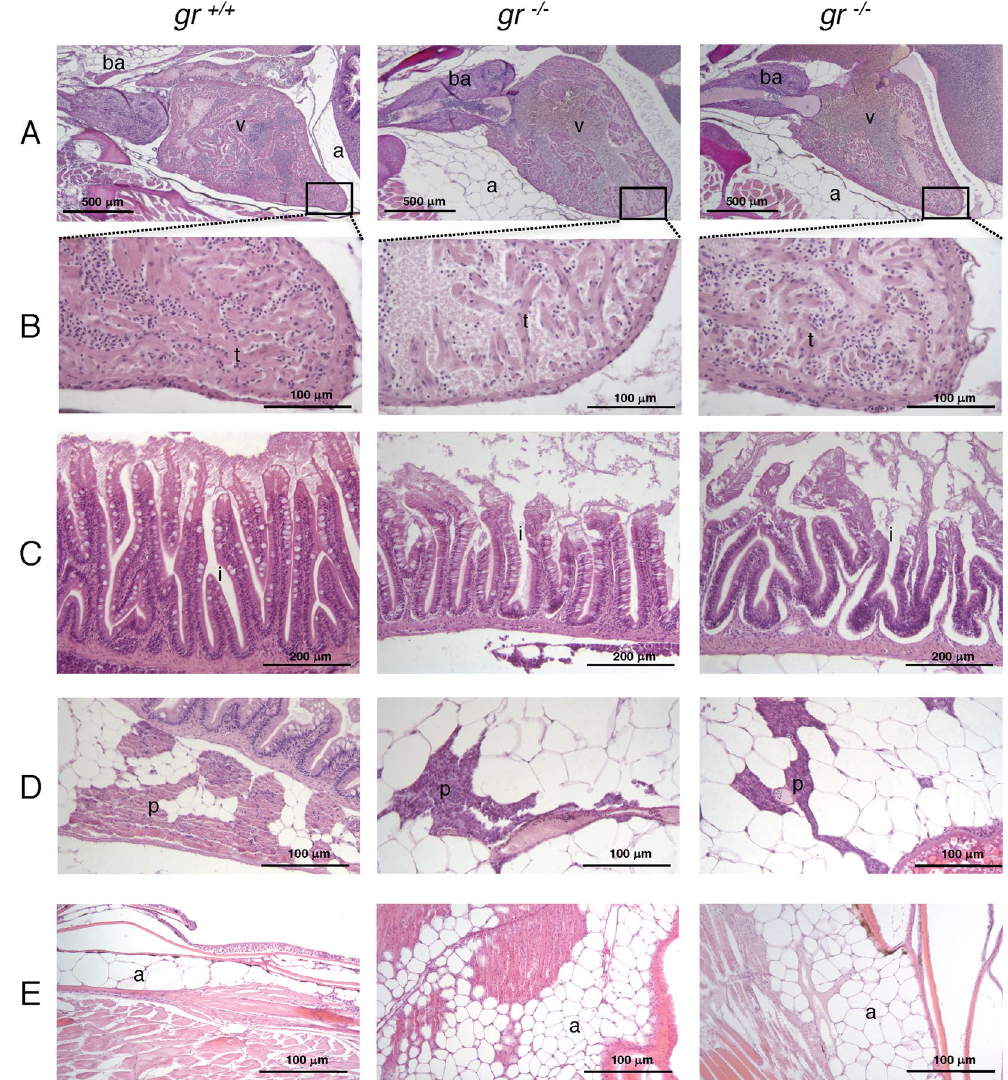
Figure 2. Histology of 8-month-old gr − / − and gr + / + zebrafish. All histological images of 8-month-old gr − / − and gr + / + zebrafish were taken from longitudinal sections stained with haematoxylin and eosin (H&E). The left panels represent wild type fish, whereas the middle and right panels show tissues from two mutant fish. ( A ) heart; ( B ) particular of the heart at higher magnification showing reduced trabecular network in the mutant samples; ( C ) intestinal mucosa with sloughing epithelium at the villous tips and reduced height of villi in mutants; ( D ) visceral view showing reduced extension of pancreas in mutants; ( E ) consistent increase of subcutaneous adipose tissue in mutants. ba = bulbus arteriosus; v = ventricle; a = adipose tissue; i = intestine; p = pancreas; t =